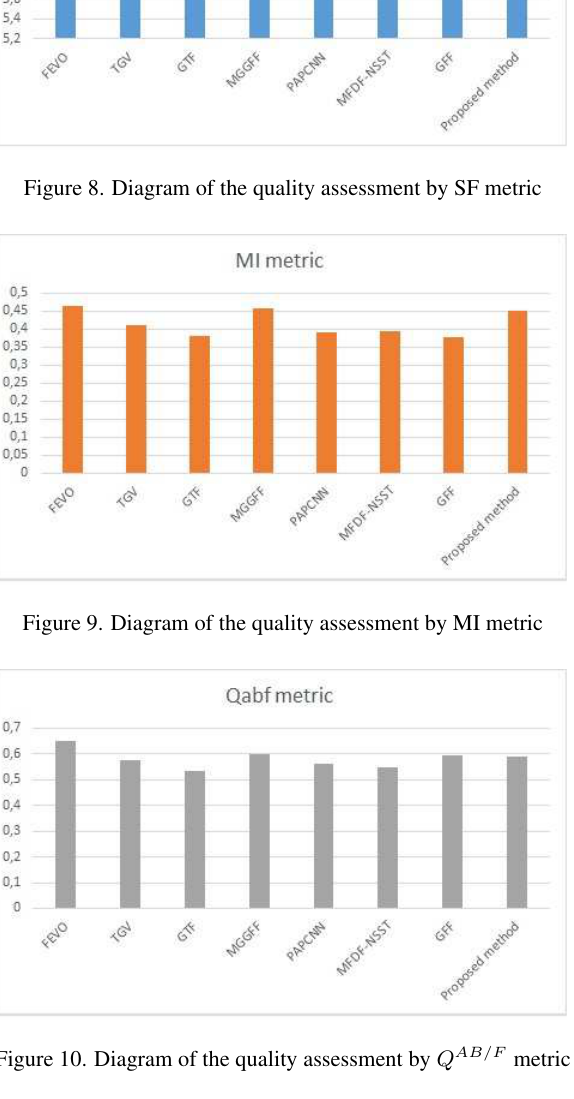
Figure 7. Comparison results: (a) original CT image; (b) original MR image; (c) proposed method; (d) FEVO; (e) TGV; (f) GTF, (g) MGGFF; (h) PAPCNN; (i) MFDF–NSST; (j) GFF